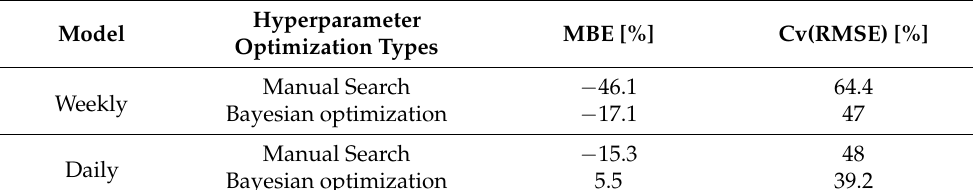
Figure 14. Load forecasting result with weekly model and building data.